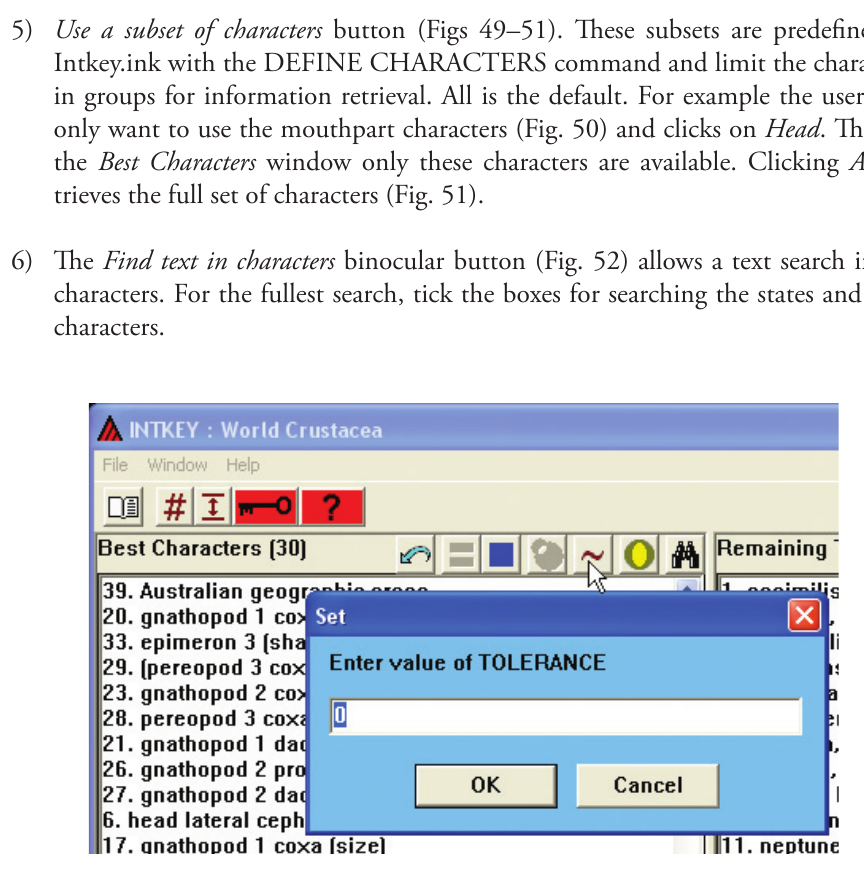
Figure 48. Set error tolerance button.